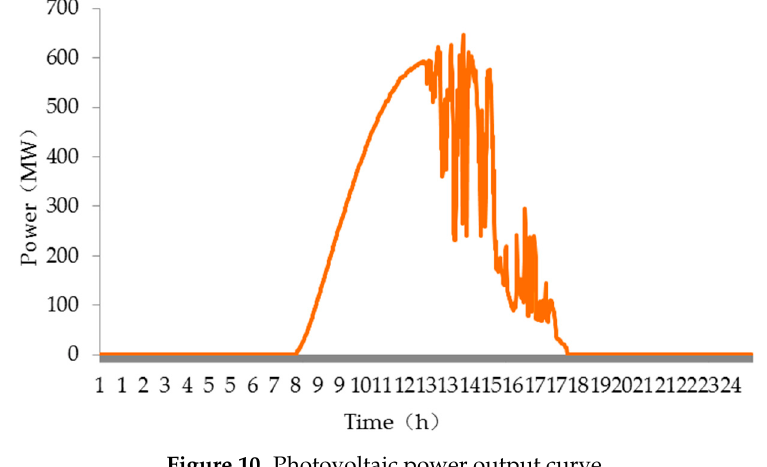
Figure 10. Photovoltaic power output curve.